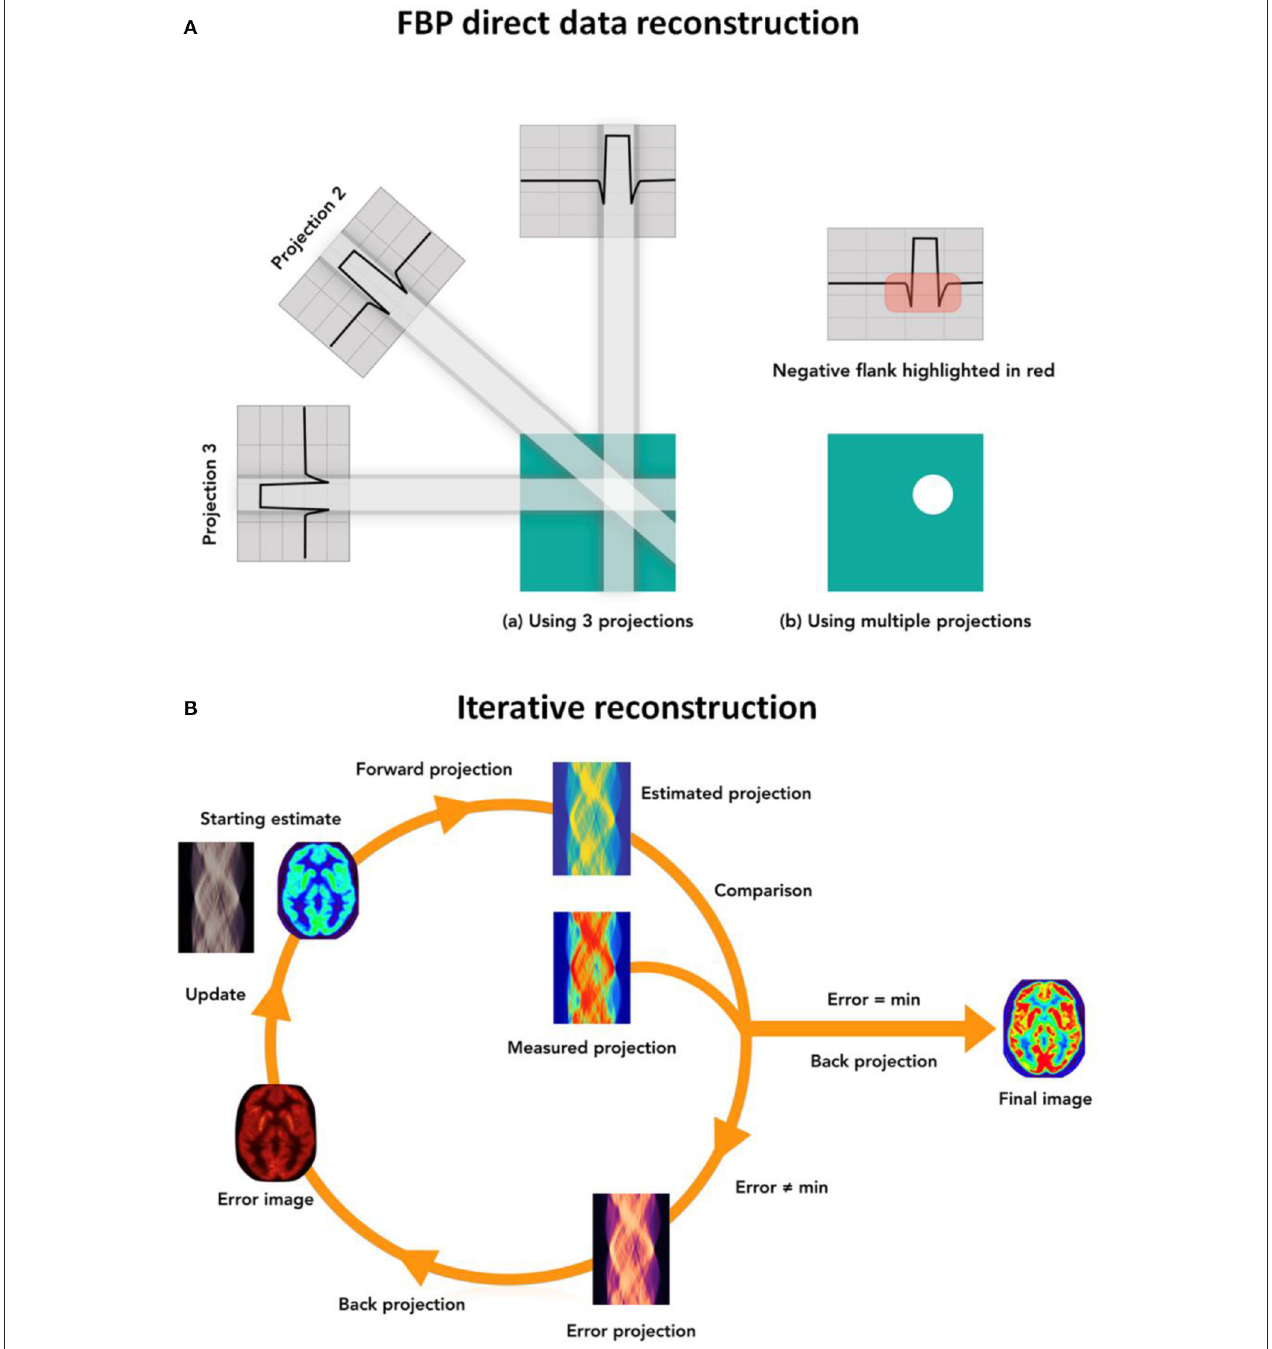
FIGURE 3 | (A) Simplified view of the direct FBP image reconstruction technique: the projected data is filtered using different filter kernels and back-projected into the image domain. Multiple projections are required to obtain the final CT image. (B) Schematic view of the iterative reconstruction process: first, a forward projection of the initial estimated image is used to create the estimated projected data; then the estimated data is compared to the acquired raw data and a set of correction factors is derived. These correction factors are back-projected and used to update the initial estimated image. All three steps describe an iterative loop, which is repeated until a predefined condition is satisfied and the final image is generated. Similar reconstruction processes apply for SPECT and PET data.